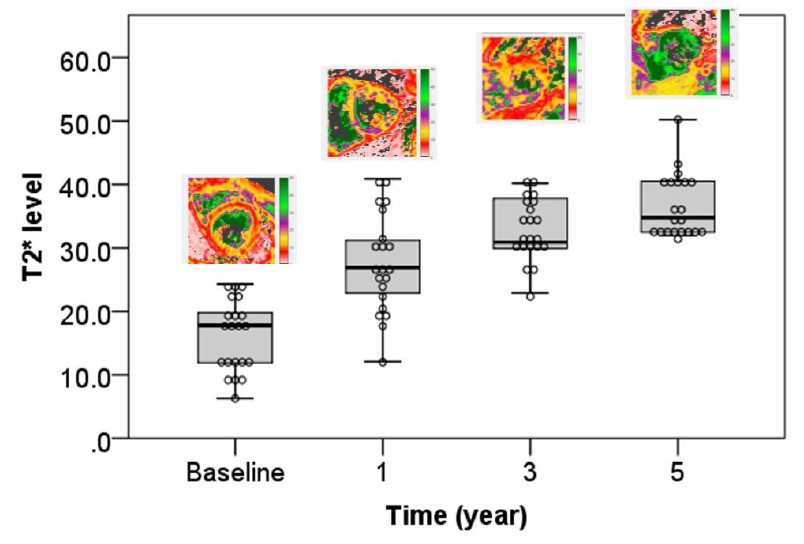
Table 3. Comparison between the parameters at baseline and one year, three years, and five years. Parameters Baseline LIC LVEF Geisser .